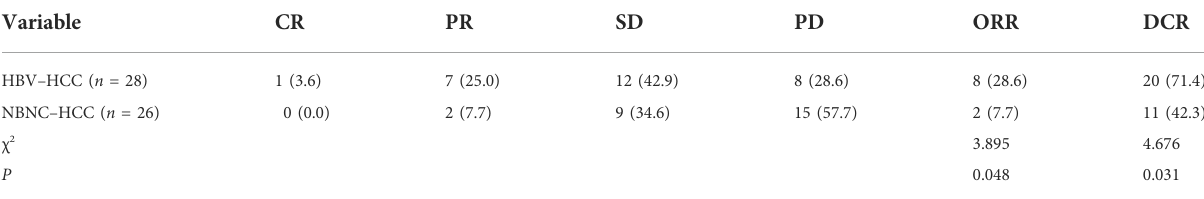
TABLE 2 Tumor response between the HBV – HCC and NBNC – HCC groups. Variable